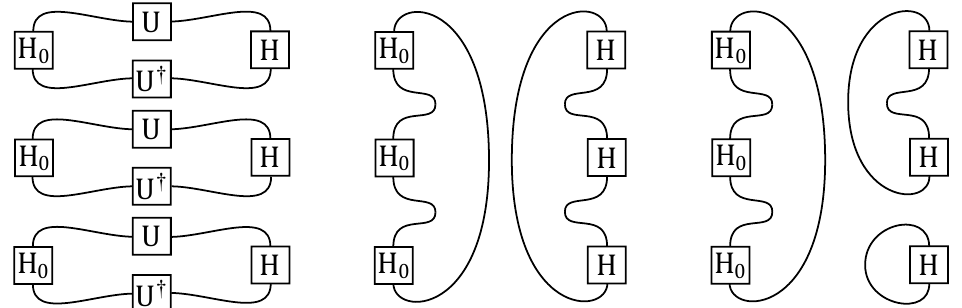
Figure 6: Illustration for integrals over unitaries. The wires represent summation over indices and integrating over random unitaries inserts a complete sets of wires. Weingarten functions Wg p αβ ´ 1 , L q weight each bra-ket combination and are the inverse of the matrix of overlaps between wire states, which is the Gramm matrix L # p α ¨ β ´ 1 q [ 85 ] with # p α q the number of cycles in the permutation α . Dominant large L configurations are diagonal contractions (middle) with identical bras and kets, whereas subleading configurations correspond with multi-trace operators